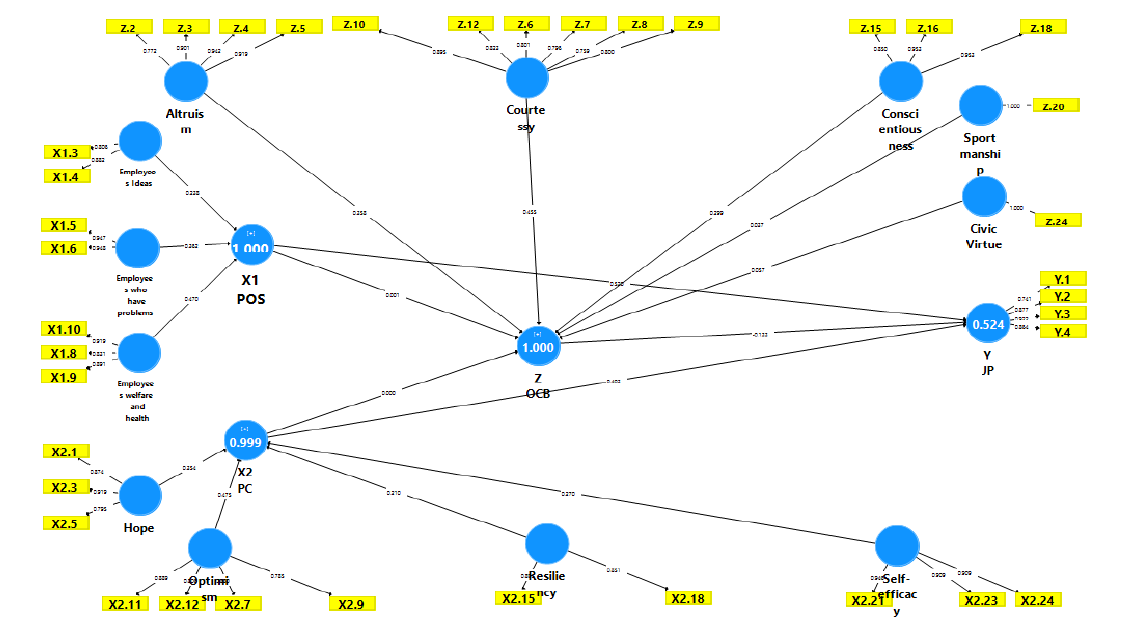
Figure 1: Convergent Validity Measurement Results